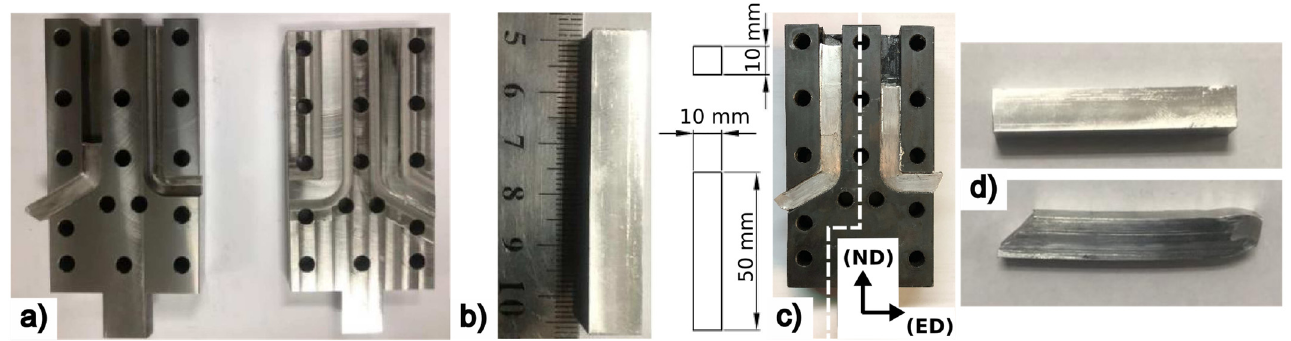
Figure 4. ( a ) Device used in the ECAE test; ( b ) dimensions of the billet used in the ECAE test; ( c ) ECAE device with billets on 120° and 90° channels 8; ( d ) undeformed and deformed billets.